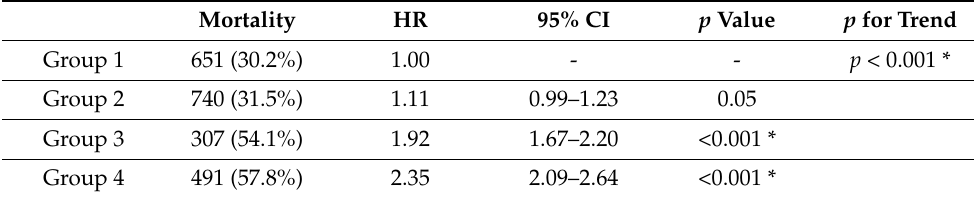
Table 2. Mortality and hazard ratios among groups.